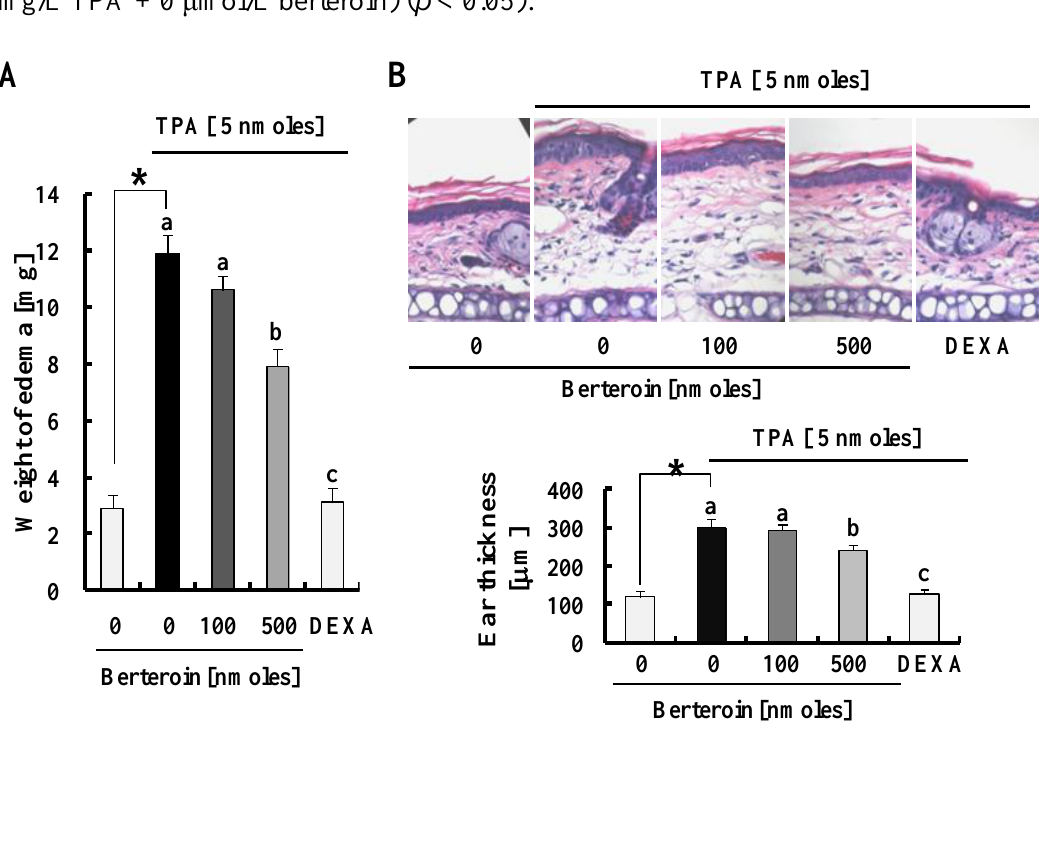
Figure 6. Berteroin inhibits 12-O-tetradecanoylphorbol-13-acetate (TPA)-induced ear edema formation in mice. ICR mouse ears were treated with berteroin (0, 100 or 500 nmole/ear) or dexamethasone (50 μg/ear) prior to topically applying TPA. The mice were sacrificed after a 4 h TPA treatment. ( A ) Changes in ear weights were measured in 6-mm diameter ear punch samples; ( B ) Each mouse ear section was stained with hematoxylin and eosin (H&E) and representative H&E images are shown in the upper panel. Ear thickness of each sample stained with H&E was quantified (lower panel). Each bar represents mean ± SEM ( n = 10); ( C ) Expression levels of inducible nitric oxide synthase (iNOS), cyclooxygenase (COX)-2, phosphorylated extracellular regulated kinase (P-ERK)1/2, and P-AKT in the ear sections of each mouse were evaluated by immunofluorescence staining (upper panel). Scale bar, 10 μm. Relative expression levels of iNOS, COX-2, P-ERK1/2, and P-AKT were compared (lower panel). Each bar represents mean ± SEM ( n = 6). * Significantly different from the vehicle-treated control group ( p < 0.05). Means with different letter (a, b or c) are significantly different among the berteroin groups ( p < 0.05).